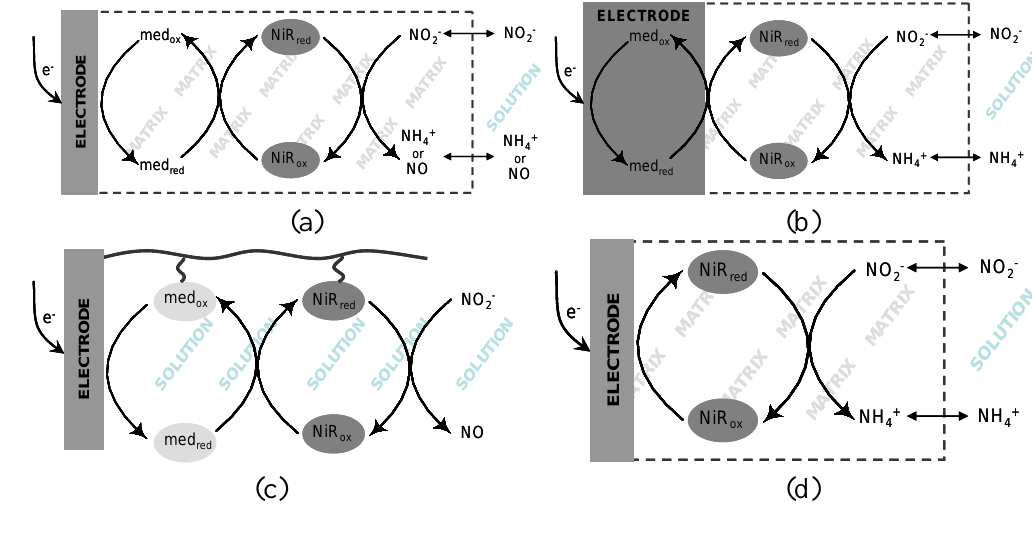
Figure 1. Schematic representations of the working principles of different enzymatic nitrite biosensors. Mediated amperometric transduction: (a) mediator and enzyme are co-immobilized on the matrix film; (b) mediator is entrapped on the working electrode material; (c) enzyme and physiological mediator linked to a DNA modified electrode. (d) Direct electrochemical transduction; (e) Potentiometric transduction; (f) Conductimetric transduction; (g) Optical transduction (med —mediator in the oxidized form; ox med —mediator in the reduced form; NiR —NiR oxidized state; NiR —NiR reduced red ox red state; dithionite (S O 42− ) works as reducing equivalents 2